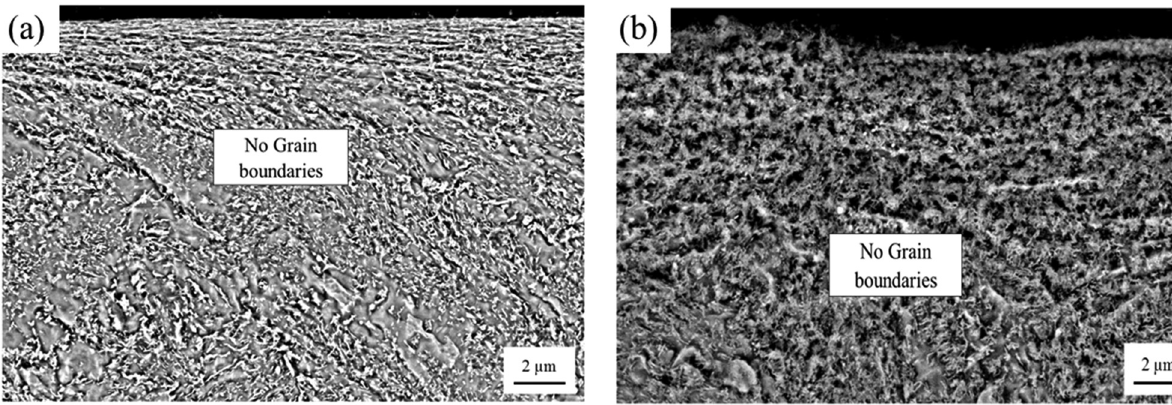
Figure 4: Microstructure beneath the machined surface of sample no.: ( a ) 2 and ( b )